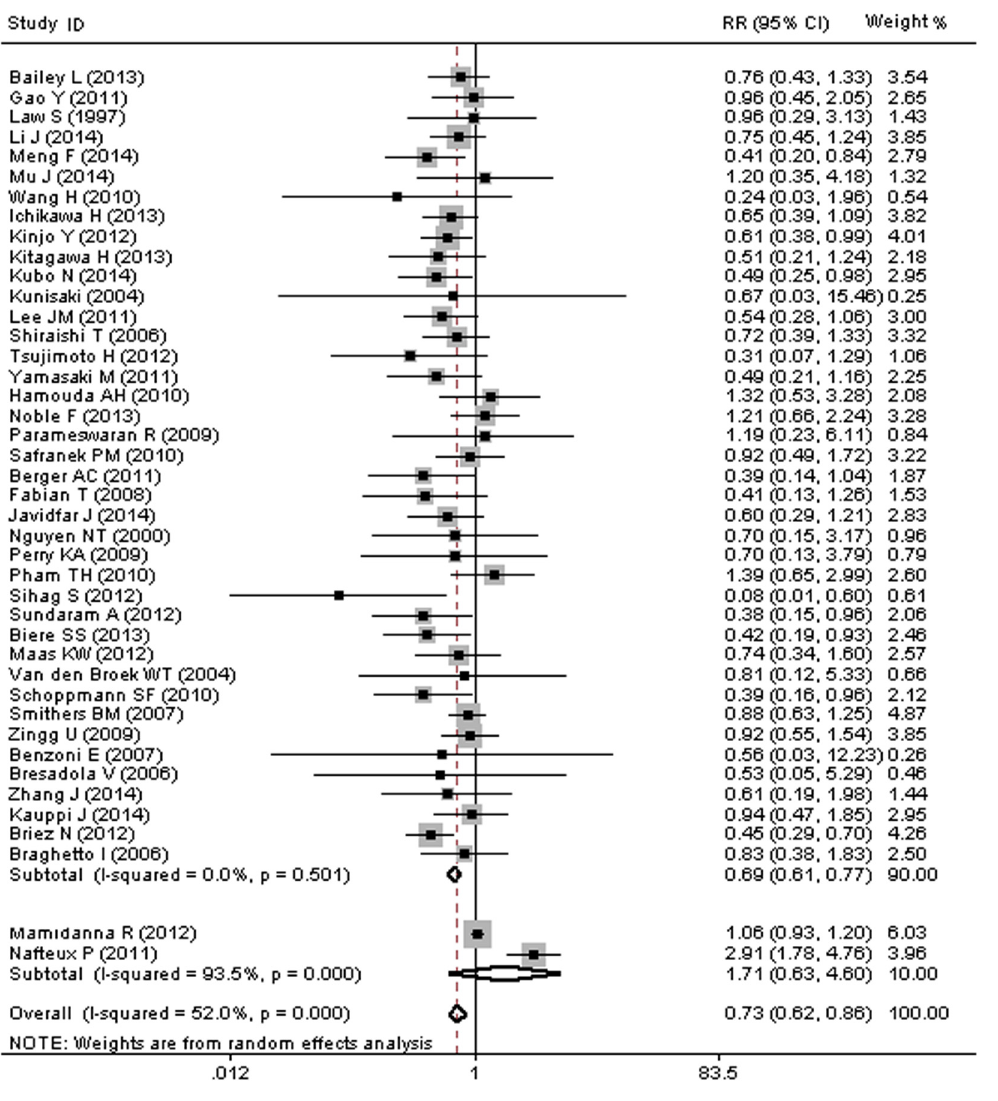
Fig 3. MIO and Risk of Pulmonary Complications